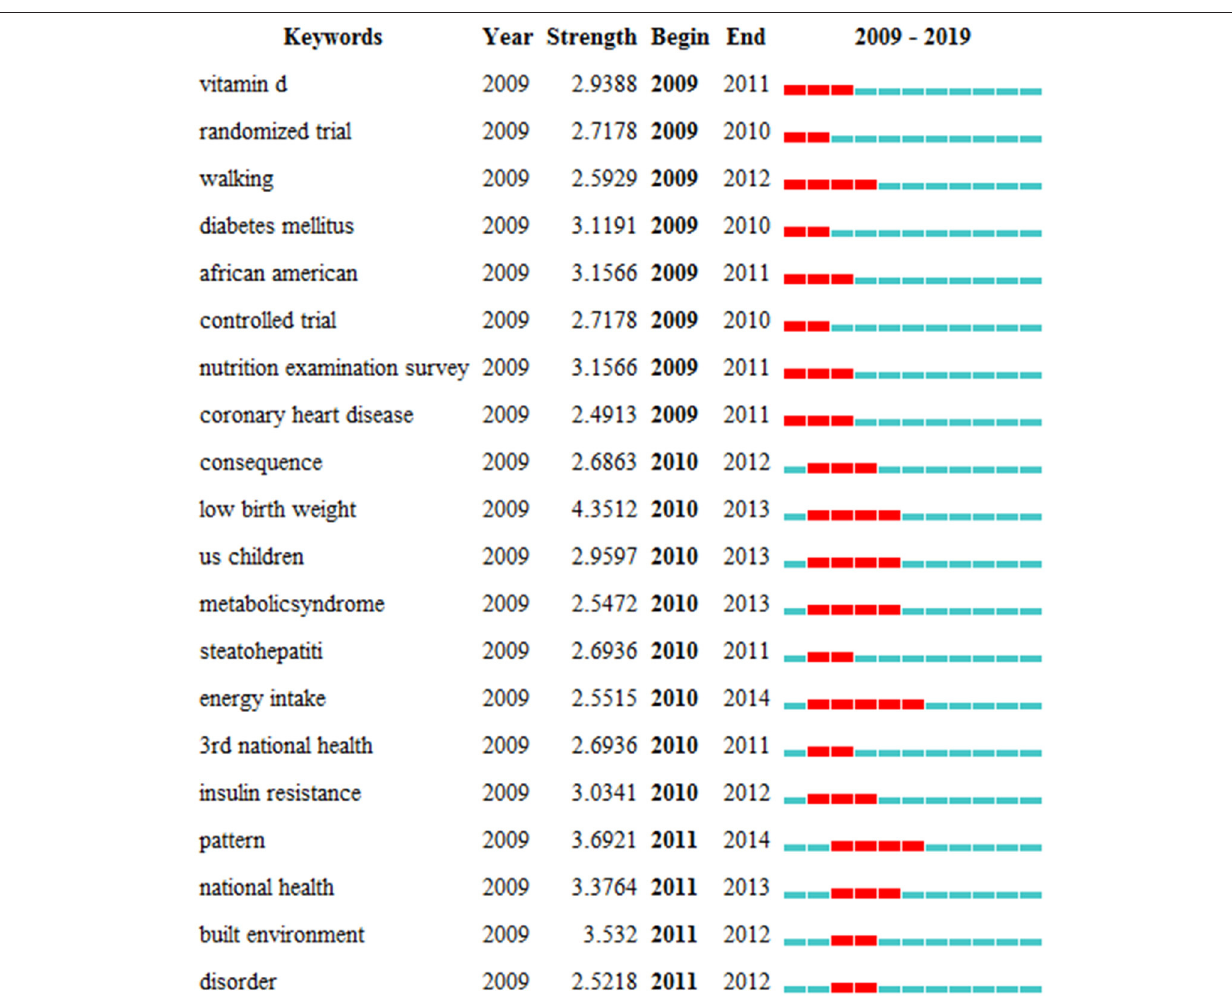
FIGURE 7 | Top 20 keywords with the strongest citation